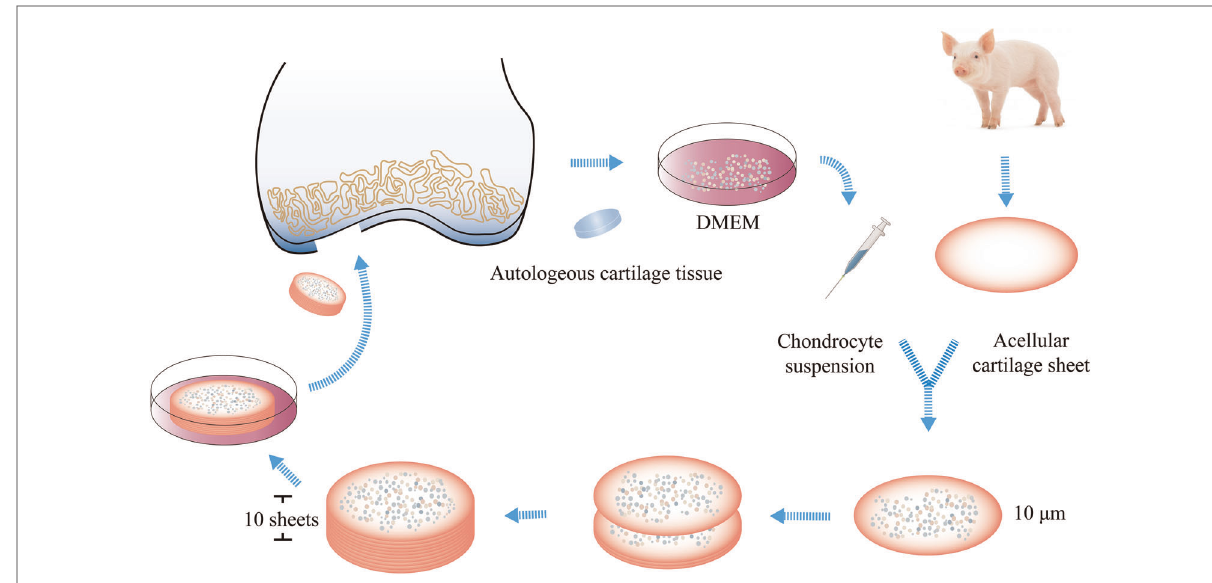
FIGURE 1 Fabrication of the patch. Healthy cartilage was harvested from the intercondylar fossa. Chondrocytes were isolated enzymatically. The cartilage used for the fabrication of acellular cartilage sheets was harvested from the ears of adult pigs. It was cut into sheets, and the sheets were decellularized. Chondrocytes were seeded on the sheet. Then, another acellular cartilage sheet was superposed on the fi rst sheet, and these procedures were continued until ten sheets were stacked together. The construct was cultured at 37°C in an atmosphere of 5% CO 2 and 95% relative humidity for 4 weeks before